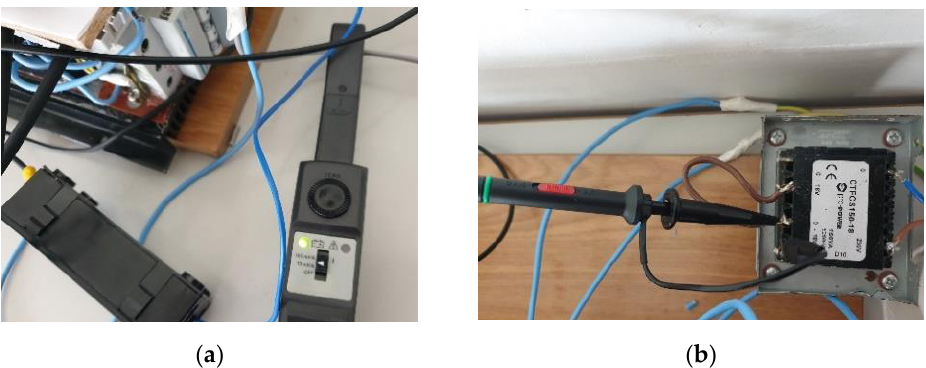
Figure 10. Instruments used for measurement in phase a : ( a ) current probe used in current measurement; ( b ) voltage transformer for galvanically isolated measurement.